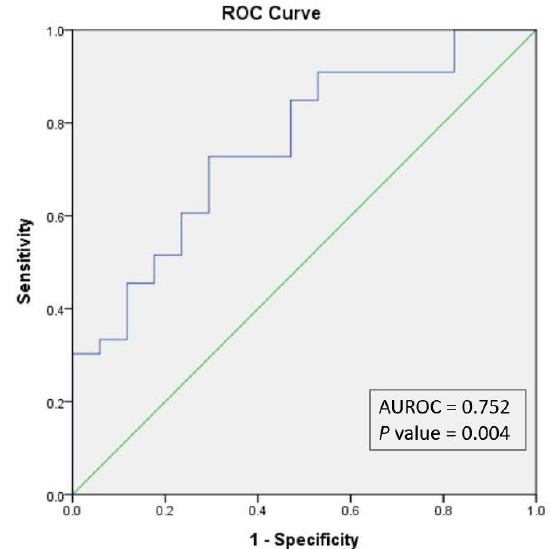
Figure 5. ROC curve for multivariate binary logistic regression. AUROC, area under the ROC